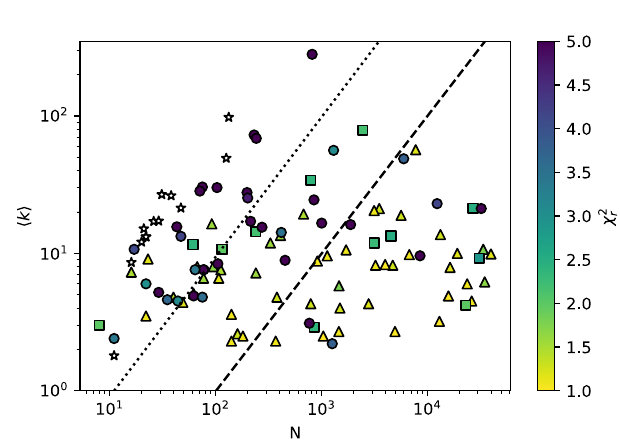
Fig. 4 Closeness and degree for Netzschleuder real-world networks. Results for the largest components of an additional 112 networks taken from the Netzschleuder archive 44 . Each point represents one network, plotted using the number of nodes N and the average degree 〈 k 〉 as coordinates. The symbol colour indicates reduced chi-square ( χ 2 r ) value with yellow being the best results (closest to 1.0). The symbol shape also indicates χ 2 r values with triangles representing best results where χ 2 r < 2 : 0, squares are for 2 : 0 (cid:4) χ 2 r < 3 : 0 and circles represent poor performance with 3 : 0 (cid:4) χ 2 r . The stars (white fi ll) are networks where our χ 2 r calculation failed due to a lack of an error estimate on each point which occurs when we have one node per k value. To the right (left) of the dashed (dotted) line, networks have a density 〈 k 〉 /( N − 1) of <0.01